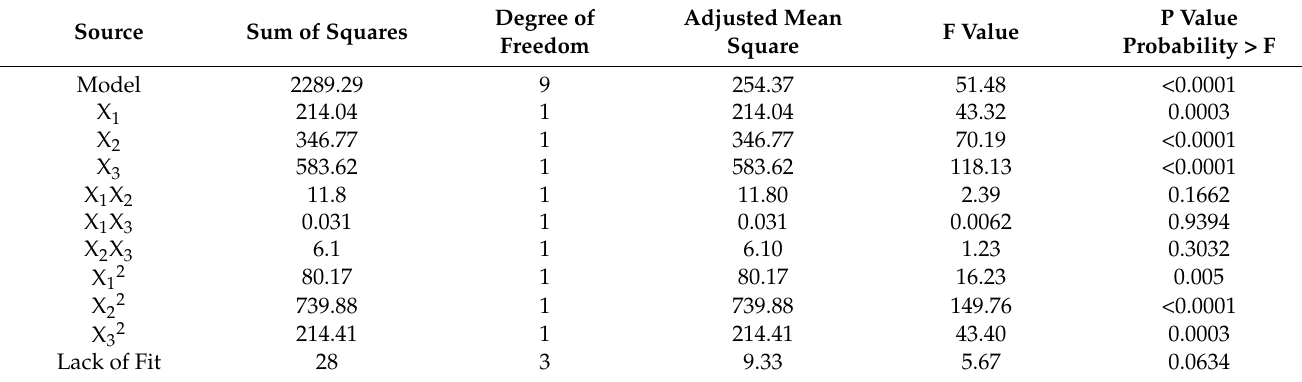
Table 5. ANOVA of the fitted models for gold